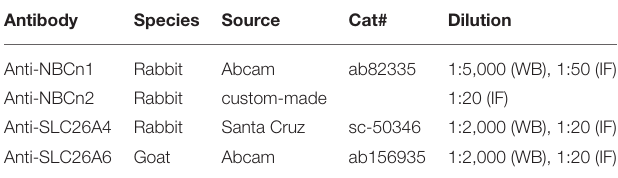
TABLE 2 | Secondary antibodies. Antibody